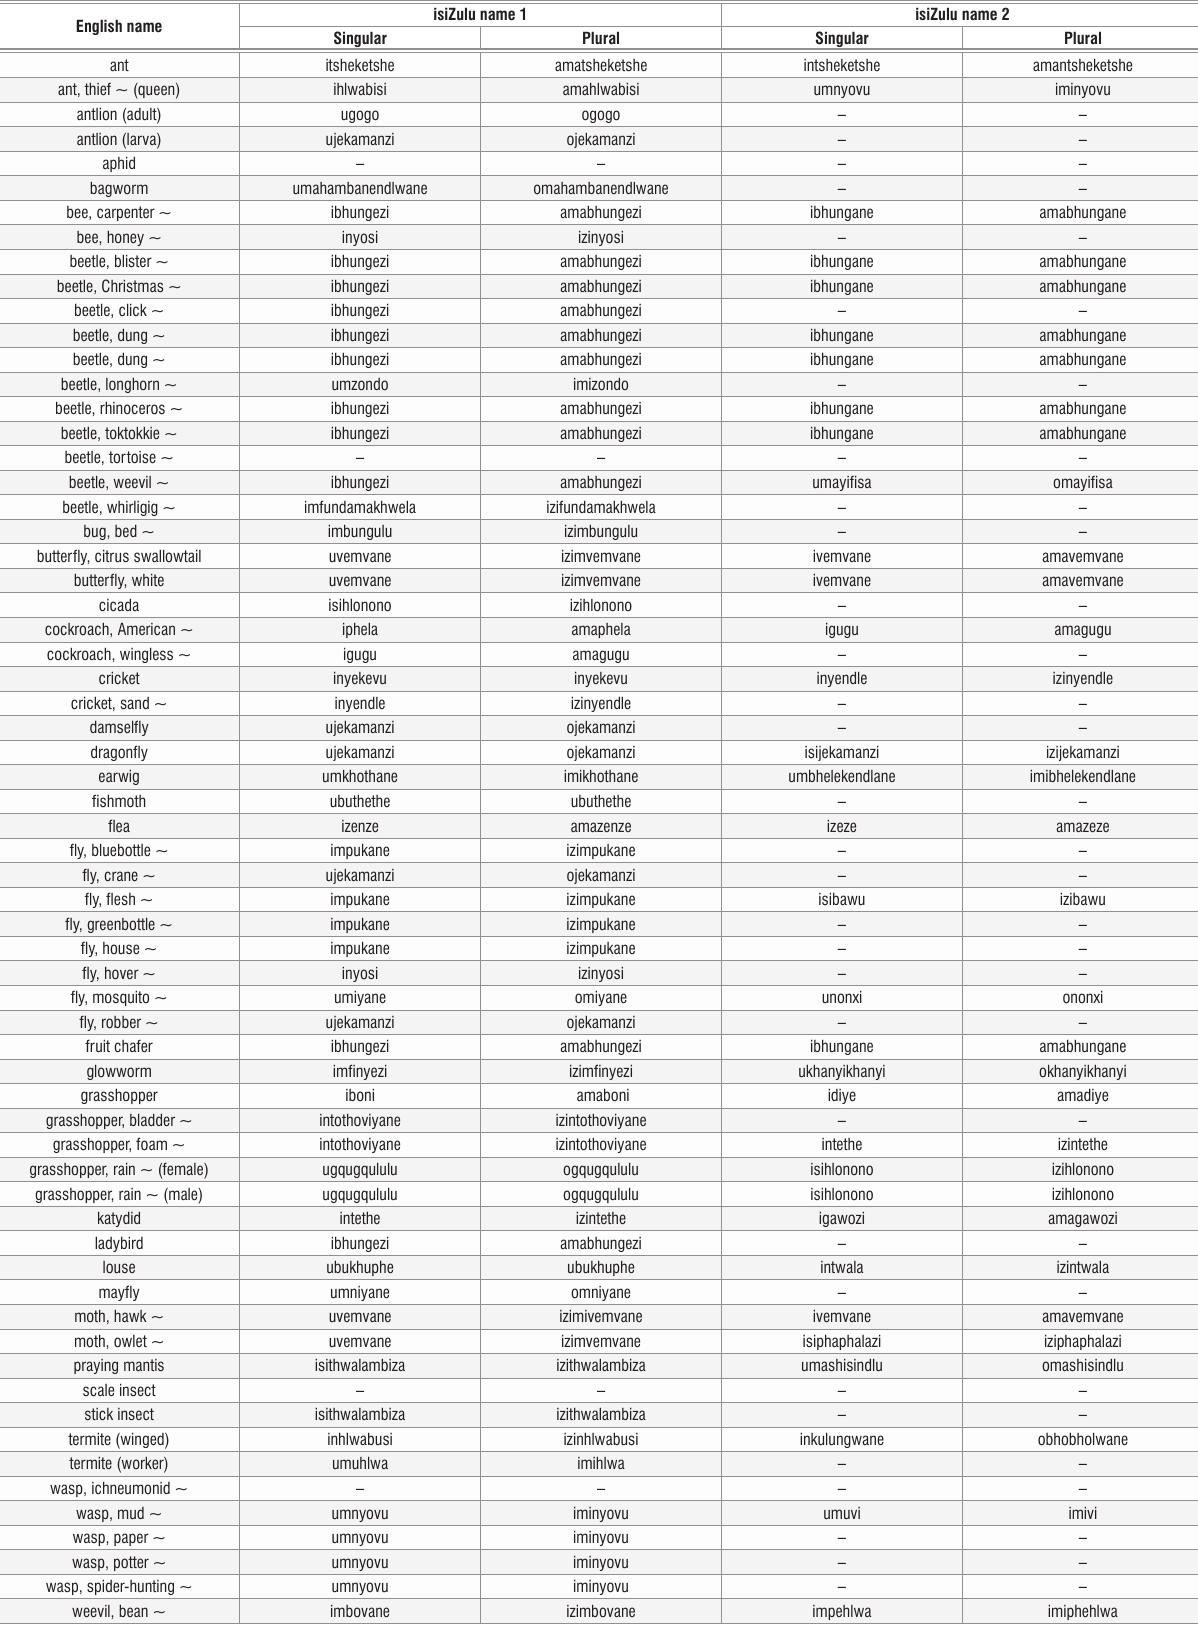
Table 5: Dominant isiZulu entomological names collected from interviews. ‘isiZulu name 1’ refers to the most common name per specimen across all regions and ‘isiZulu name 2’ refers to the second most common name across all regions (where this differs from isiZulu name 1 and is known by five or more people). ‘–’ indicates that no isiZulu name showed consistency (fewer than five people knew the name), often because that particular insect was not known to the